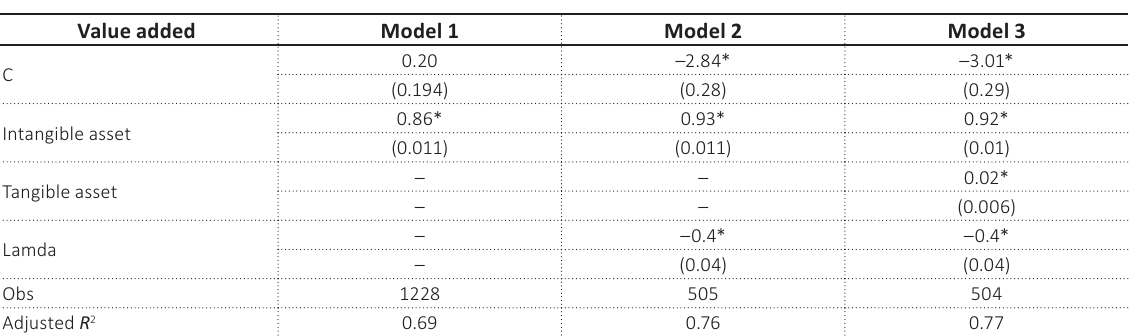
Table 5. The impact of intangible assets on a firm’s value added